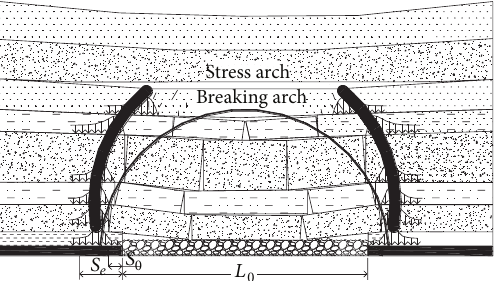
Figure 1: The “two-arch” structure of mining